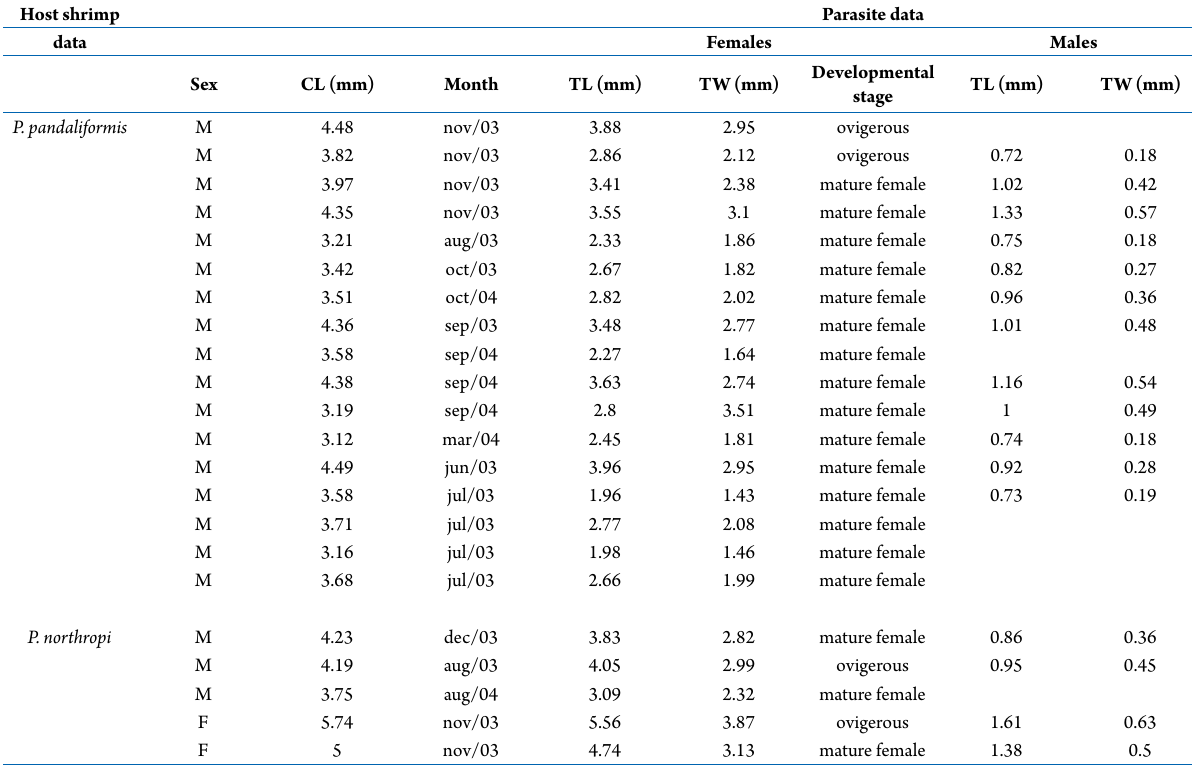
Table 1. Number of specimens and carapace length (CL) of males (M) and females (F) of Palaemon pandaliformis and P. northropi infested by Probopyrus sp. Developmental stage, total length (TL) and total width (TW) of males and females of Probopyrus sp.